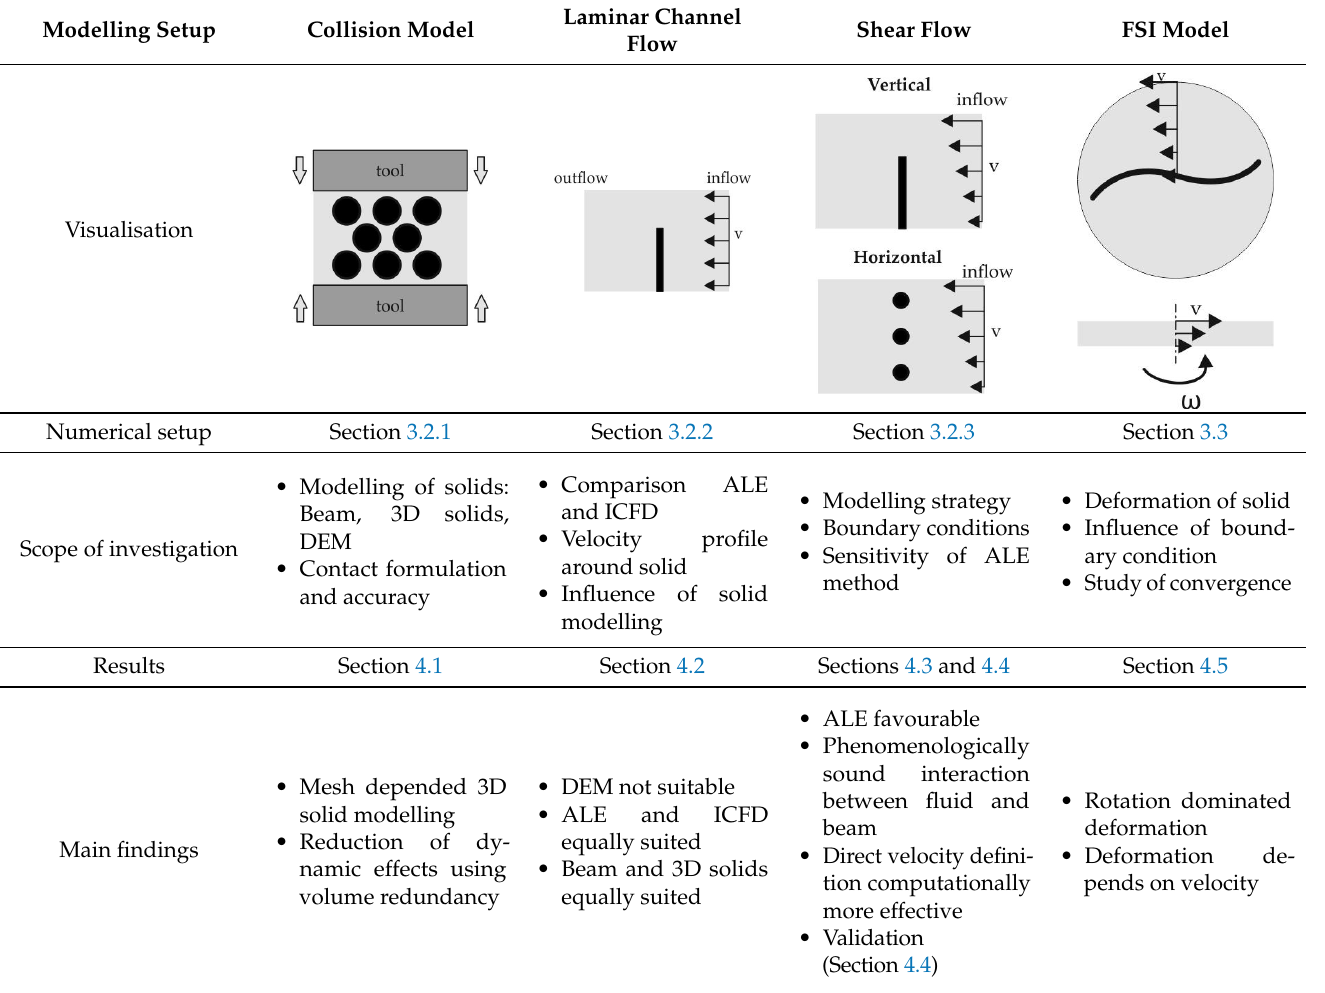
Table 4. Model evolution for the development of a modelling strategy and summarised findings.